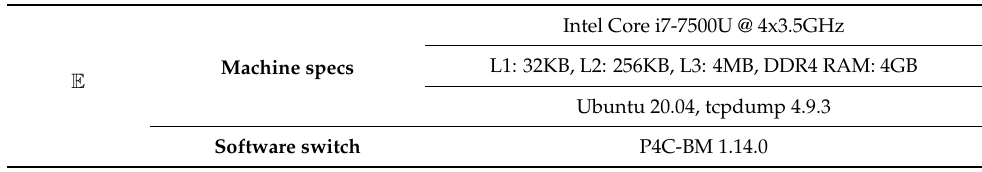
Table 5. Specifications of hardware and software used in the case